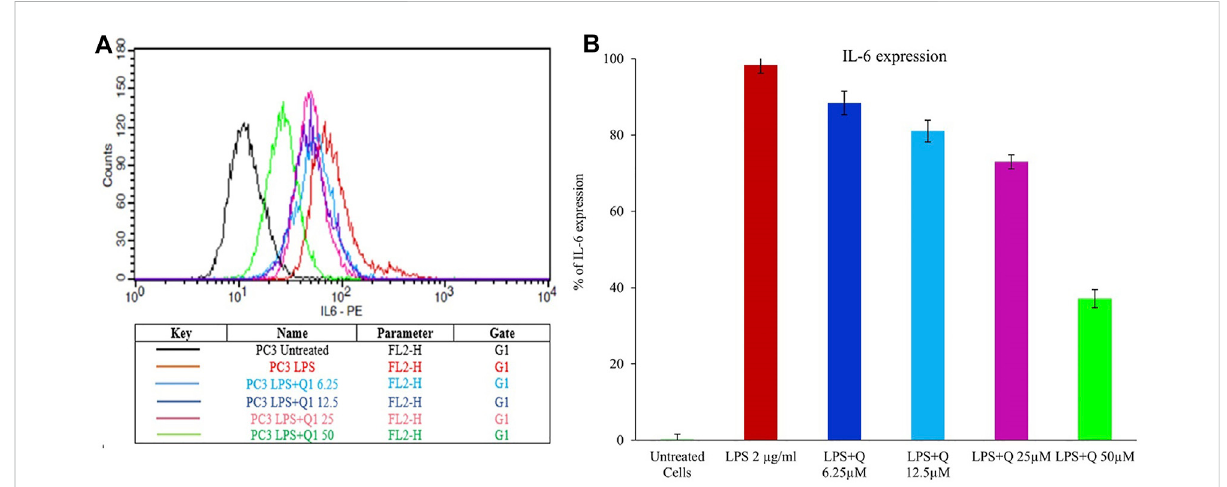
FIGURE 7 Estimation of the effect of quercitrin on IL6 expression. (A) Graph of mean fl uorescence intensities of IL-6 stained with anti IL6 antibody, which isconjugated withphycoerythrin fl uorochromeupontreatmentofquercitrin(0 – 50 µM)inLPStreatedPC3cellline. (B) Thebargraphrepresentsthe % of IL-6 expression upon treatment of